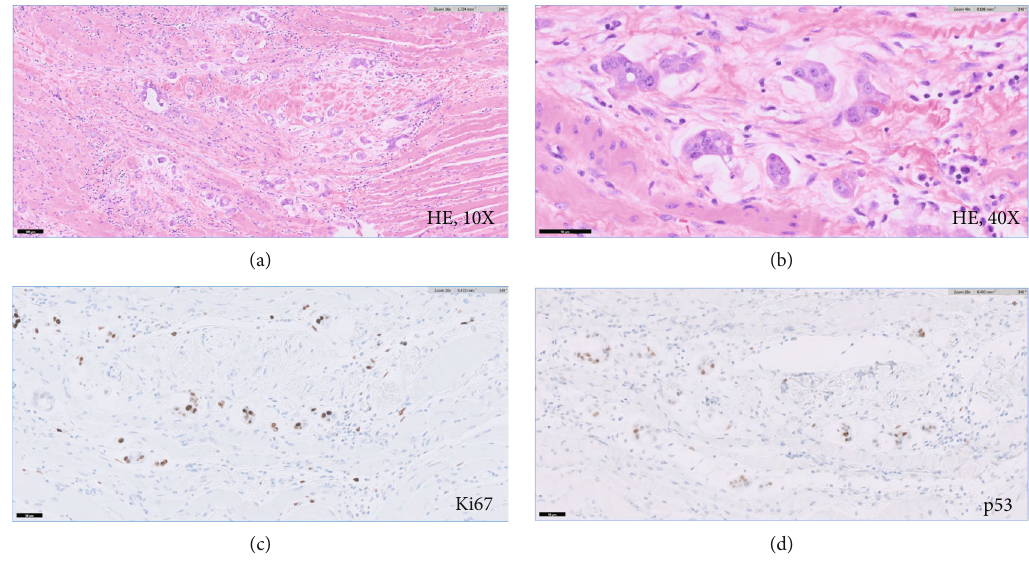
Figure 5: Microscopic examination of the recurrent tumor showing invasive, moderately di ff erentiated adenocarcinoma. The tumor cell islands displayed an in fi ltrative pattern at 10x magni fi cation (a), with marked structural and cellular atypia demonstrated at 40x magni fi cation (b). The malignant glands showed a high proliferative index on Ki-67 (c), while p53 was wild-type